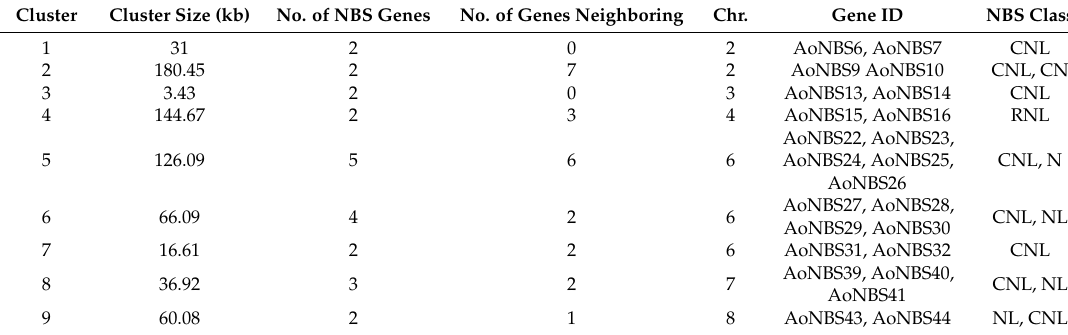
Table 2. Cluster analysis of NBS-LRR domains in